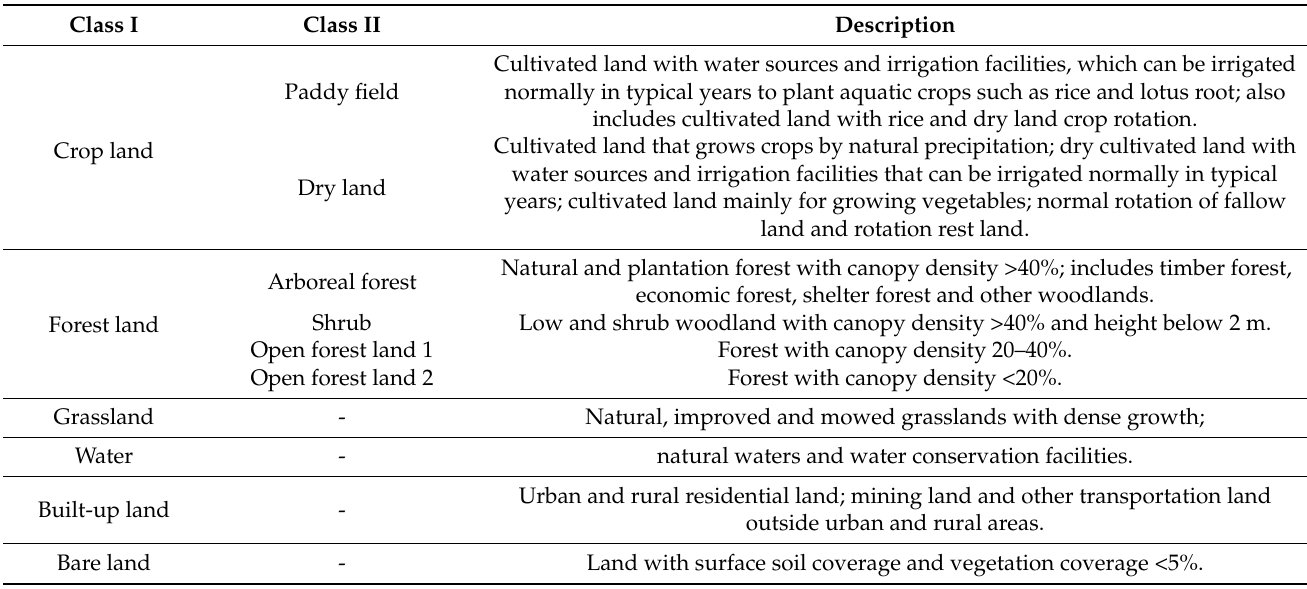
Table 1. The information of land use type.